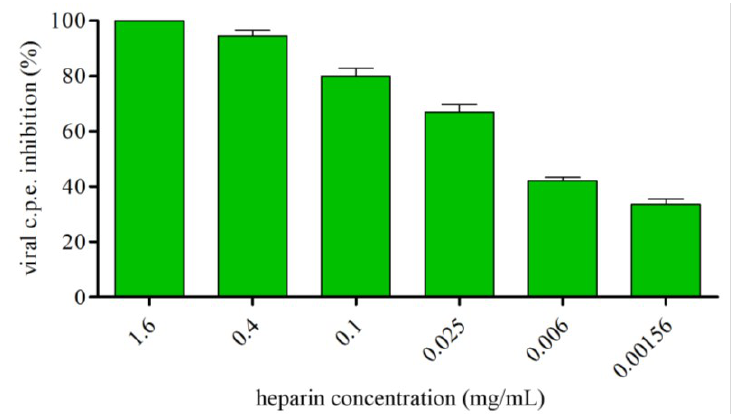
Figure 3. TosV infection is decreased in the presence of heparin. TosV was incubated with different concentrations of heparin for 1 h at 37 °C in culture medium prior to infection of Vero cells. At 48 h post infection c.p.e. was measured by neutral red uptake assay. The data shown correspond to the results of a representative set of two independent experiments performed in quadruplicate.